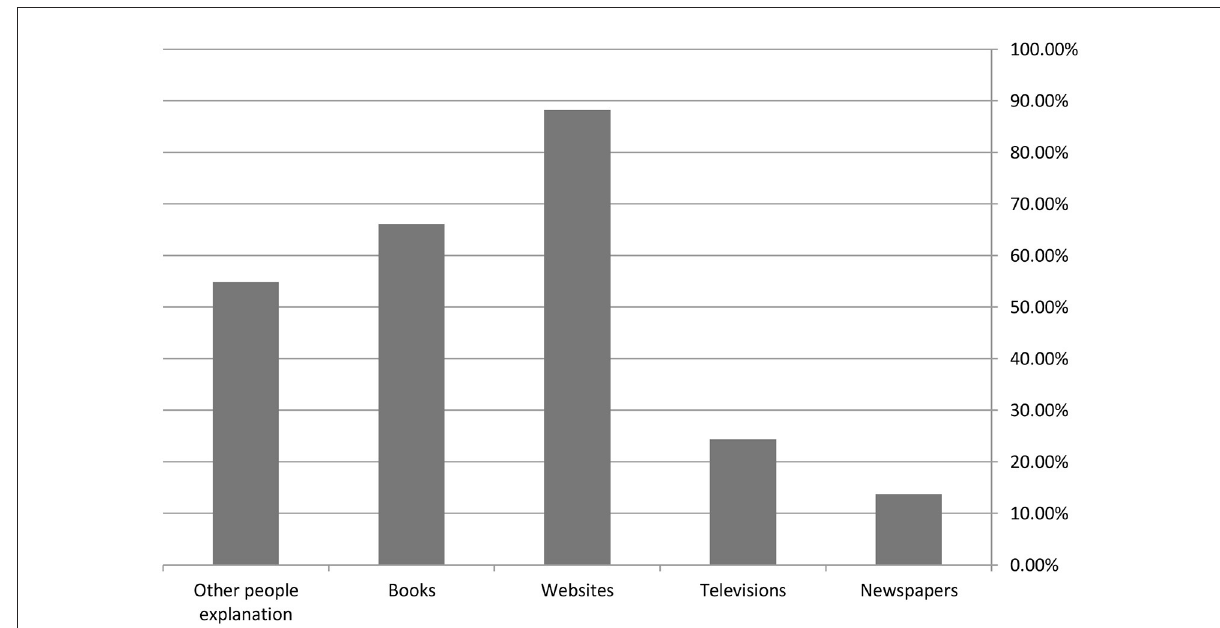
FIGURE1 Sources of information that the participants used to learn about mental